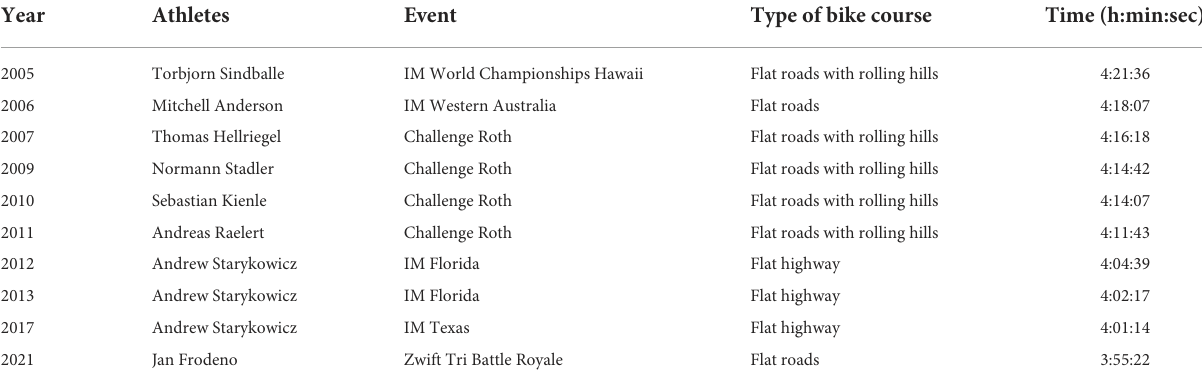
TABLE 6 World record cycling times in an Ironman TM since